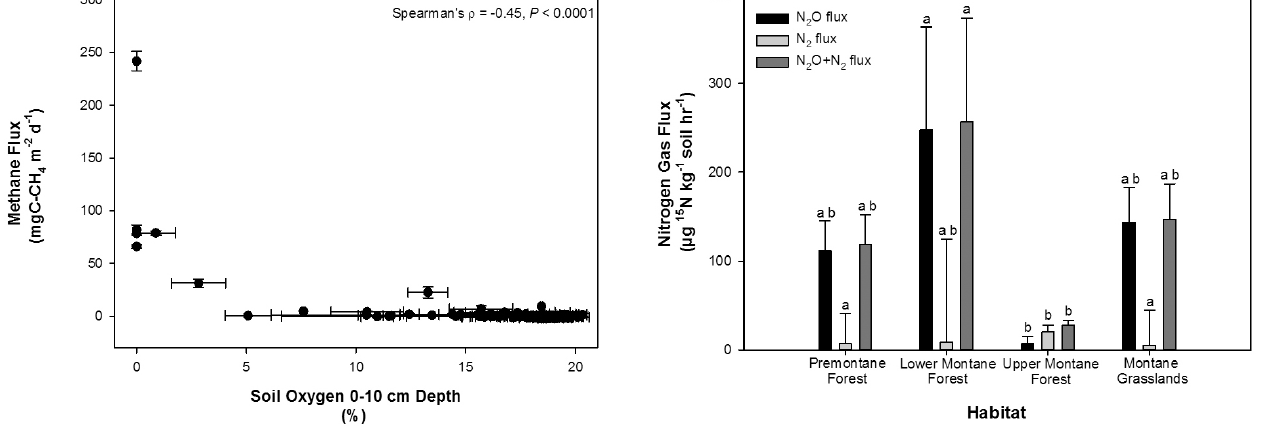
Fig. 4. Mean plot-level CH 4 flux against mean plot-level soil O 2 for the 0–10cm soil depth. Bars indicate standard errors.